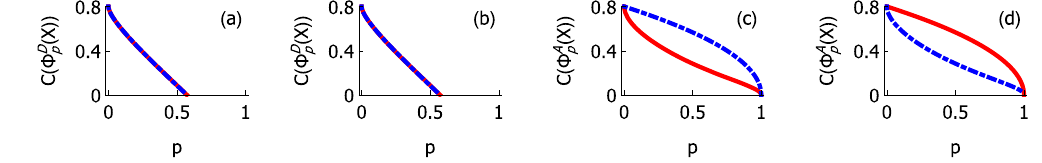
Figure 4. Concurrence of an X state as a function of the channel strength parameter p under depolarizing ( a )– ( b ) and amplitude damping ( c )–( d ) channel. Here the red and blue curves correspond to the cases with local noise on qubit U and L respectively. In ( a ) and ( c ) we have chosen ρ ρ ρ =